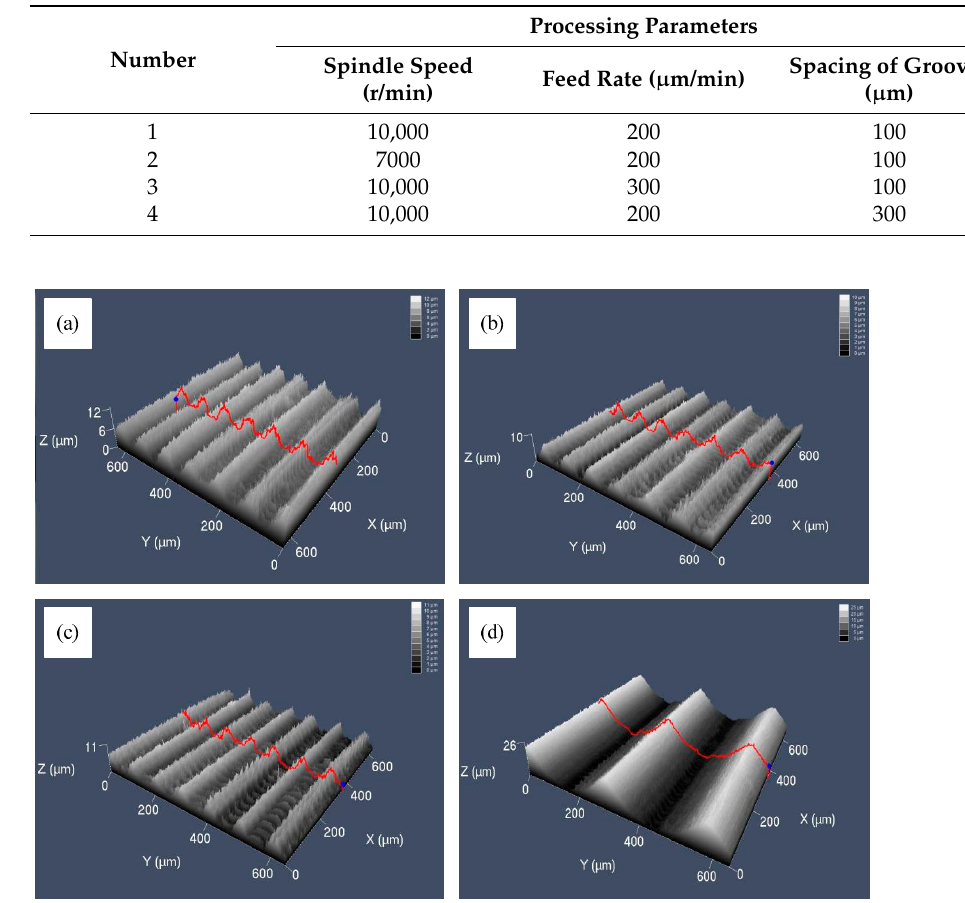
Figure 12. Actual microgroove surfaces: ( a ) surface 1; ( b ) surface 2; ( c ) surface 3; ( d ) surface